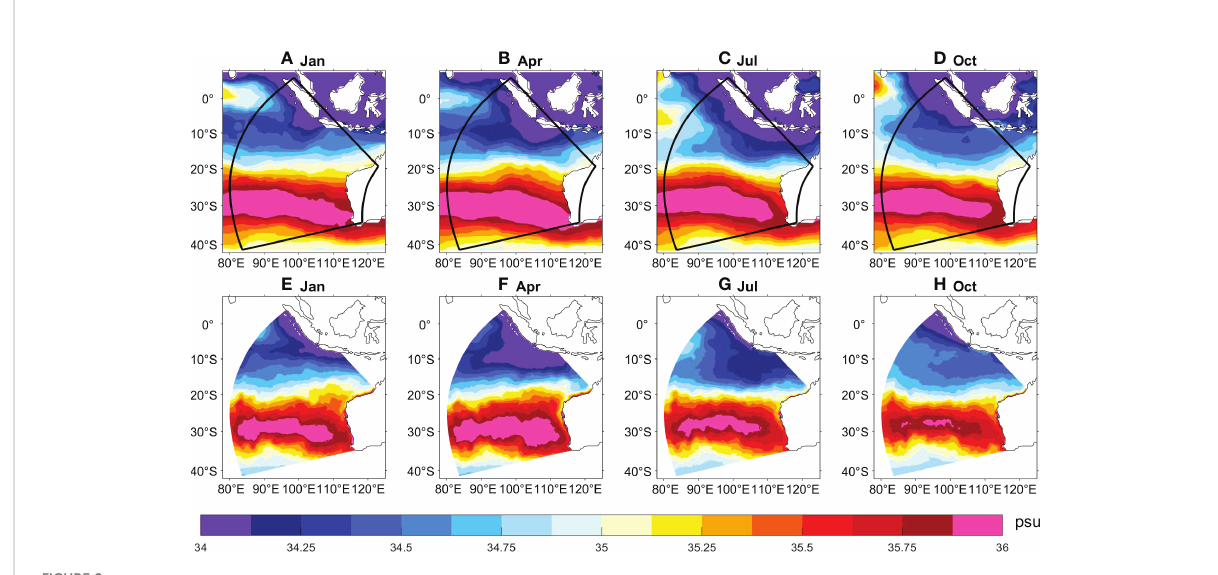
FIGURE 2 Monthly climatology of SSS (psu) in January, April, July, and October of 1995-2016 derived from IAP (A-D) and ROMS Ctr (E-H)